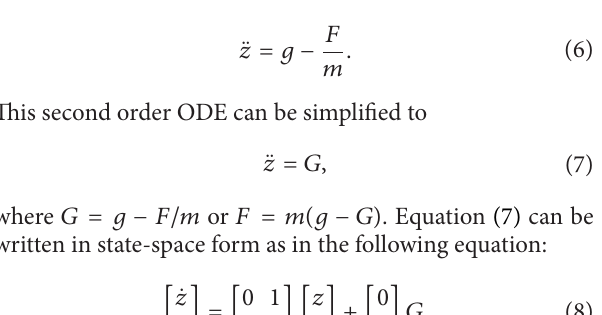
Figure 2 where we have utilized MPC to design the three controllers. The attitude controller generates 𝜏 𝜙 , 𝜏 𝜃 , and 𝜏 𝜓 actuator signals whereas the altitude controller generates required thrust for the system. The position controller con- trols position in the 𝑥 and 𝑦 directions and generates control signals 𝜃 and 𝜙 which, when combined with the 𝜓 signal, act as reference signals to the attitude